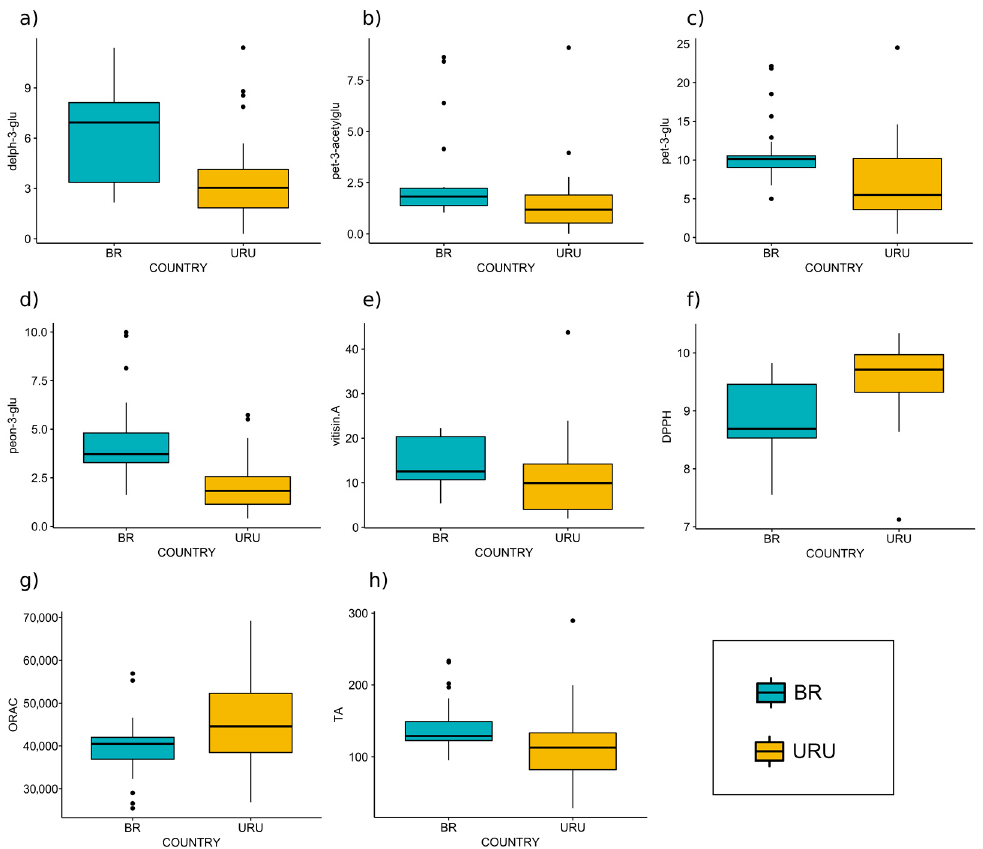
Figure 4. Boxplots of the eight compounds selected by the F ‐ score, along with SVM classification. ( a ) delph ‐ 3 ‐ glu variable; ( b ) pet ‐ 3 ‐ acetylglu variable; ( c ) pet ‐ 3 ‐ glu variable; ( d ) peon ‐ 3 ‐ glu; ( e ) vitisin A variable; ( f ) free radical scavenging capacity (DPPH) variable; ( g ) oxygen radical absorbance capacity (ORAC) variable; and ( h ) total anthocyanins (TA) variable.